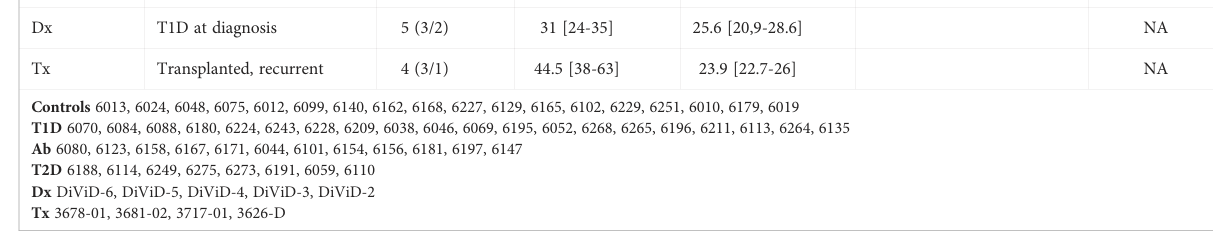
TABLE 2 List of abbreviations of examined genes and sample numbers from the nPOD and DiViD repository. AANAT aralkylamine N-acetyltransferase ACER1 alkaline ceramidase 1